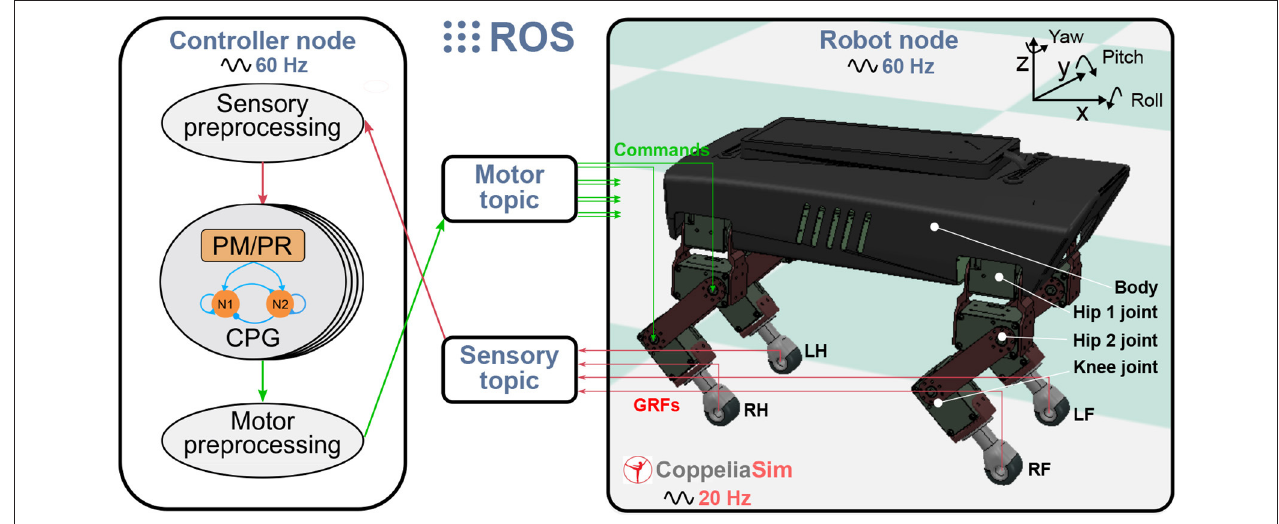
FIGURE 2 | Experimental platform with the quadruped robot in CoppeliaSim (20 Hz) communication with the adaptive neural controller. The controller and the robot are regarded as two ROS nodes (60 Hz) and communicate with each other through two ROS topics. A motor topic transfers commands from the motor preprocessing unit of the controller node to the robot joints while a sensory topic acquires GRF signals from the robot and then send them to the sensory pre-processing unit of the controller